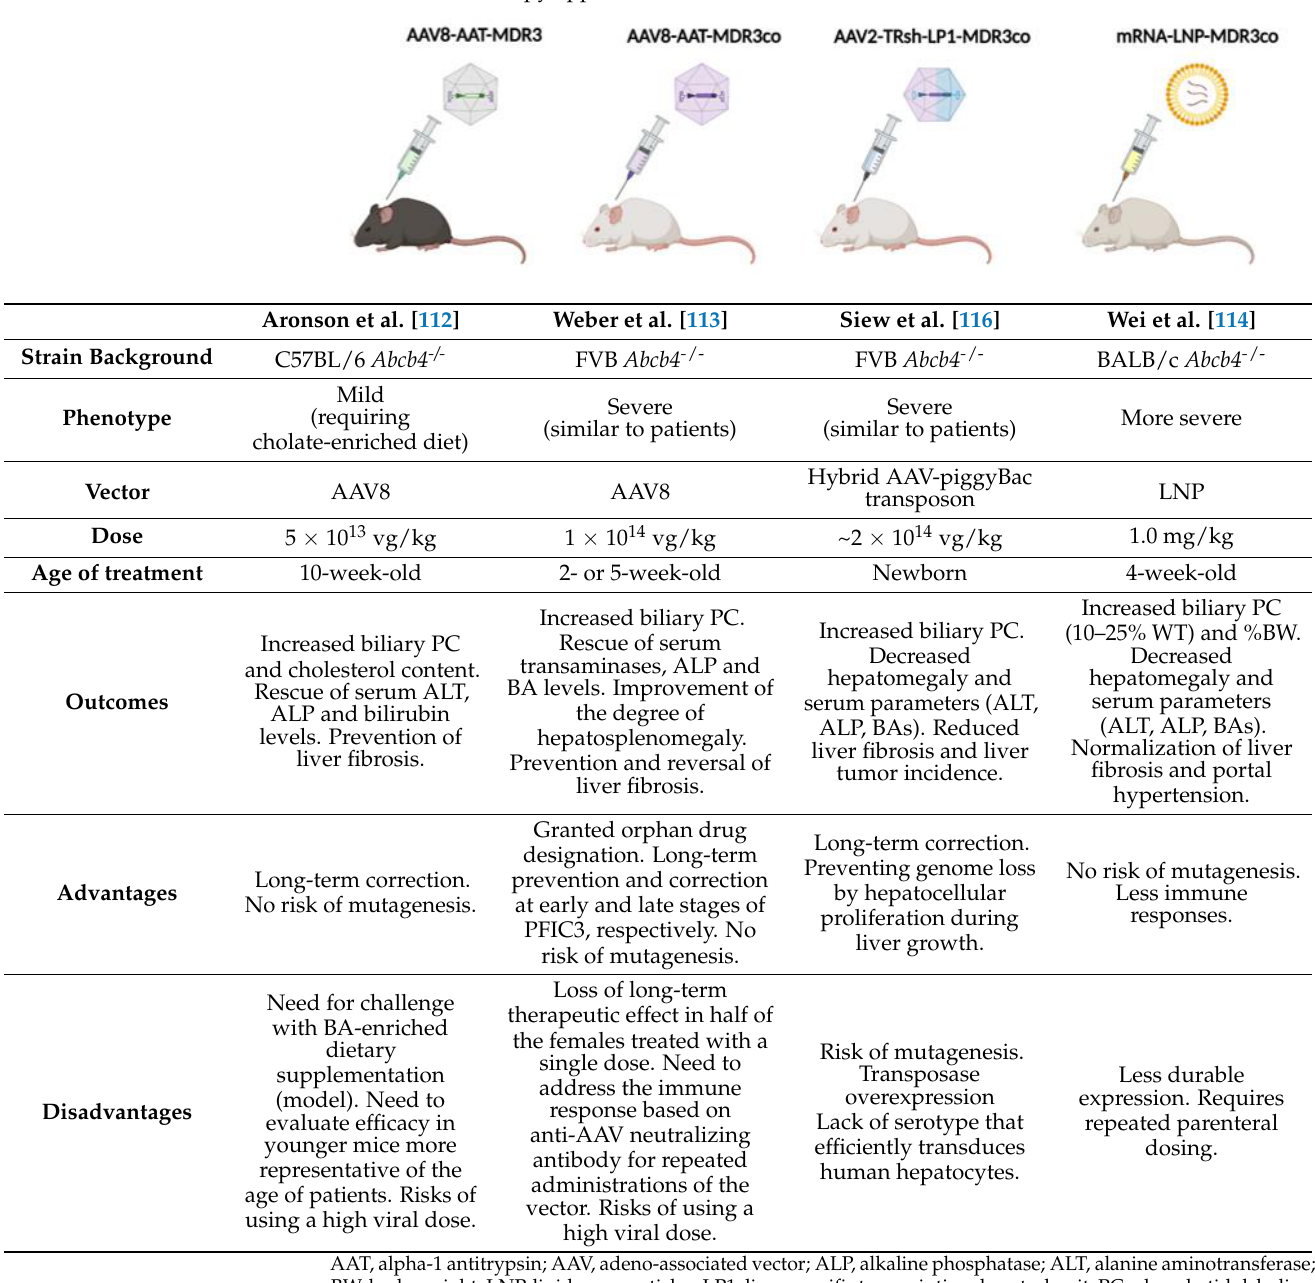
Table 2. Gene therapy approaches for PFIC3.